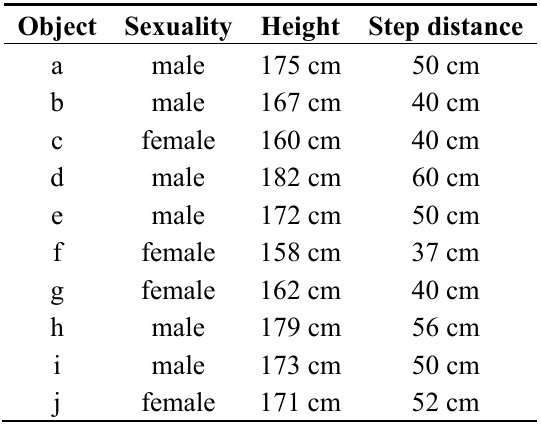
Table 2. Attribute Features of Experiment Object.